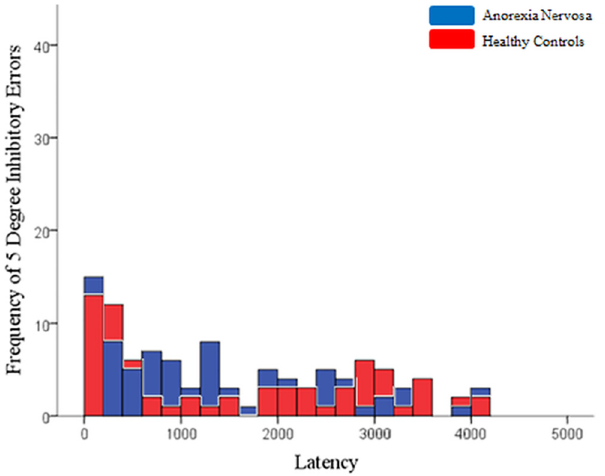
Fig 1. Frequency of individual memory guided-saccades inhibitory error latencies at 5° targets, within 200 millisecond bins.